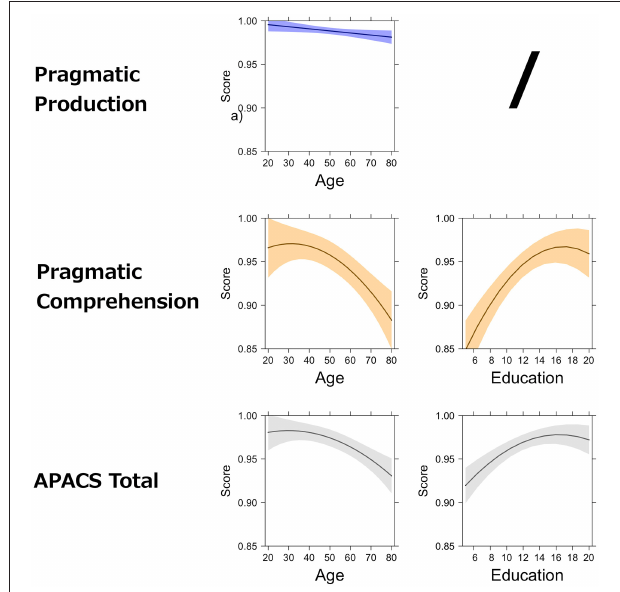
FIGURE 3 | Effect of demographic variables on APACS composite scores. The figure shows the partial effects of age and education on APACS composite scores, as estimated by regression analysis. The figure is an array displaying the APACS composite scores (first column) and the effect of age (second column) and education (third column). A slash (“/”) indicates that the effect was not significant in the regression analysis. The black line in each plot represents the predicted score at the APACS composite score. The colored bands around the line represent point-wise confidence bands around the prediction. Light blue is used for the Pragmatic Production score. Light orange is used for the Pragmatic Comprehension score. Gray is used for the APACS Total